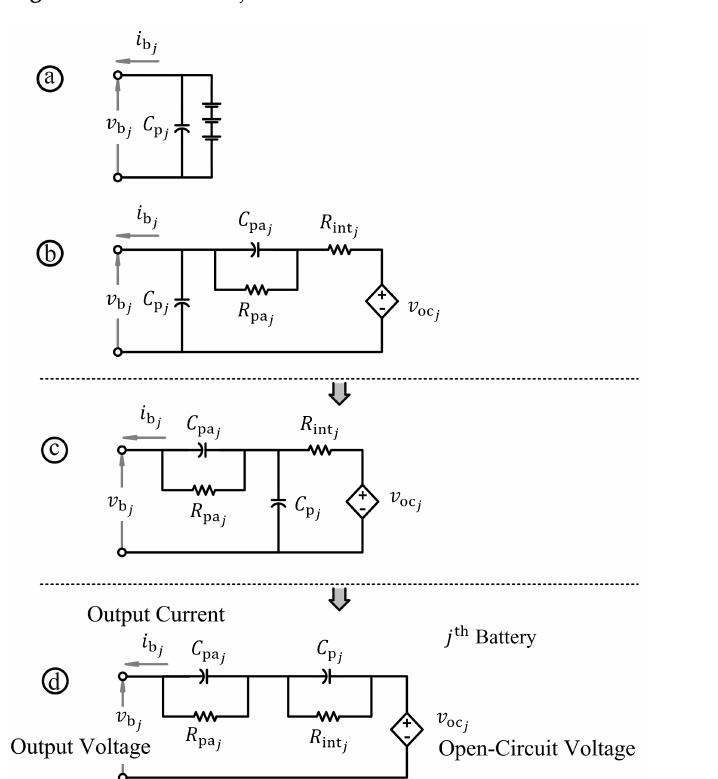
Figure 3. Derivation of the electrical model for the modules: ( a ) actual depiction of a battery with a parallel capacitor, ( b ) circuit based on the first-order ECM of the battery, ( c ) first approximation of the ECM, ( d ) final